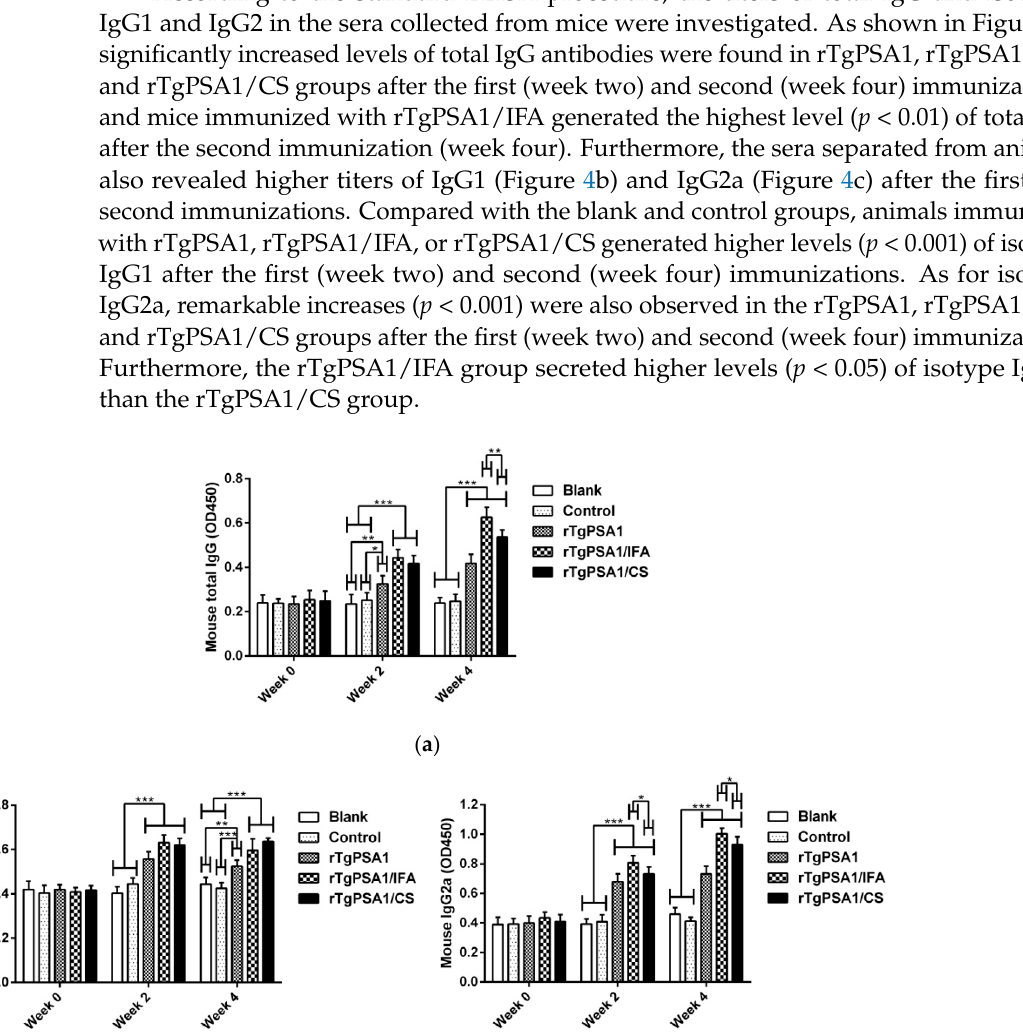
( d ) Figure 5. Cytokine secretions in mice. Commercially available ELISA kits were used to determine levels of ( a ) IFN- γ , ( b ) IL-4, ( c ) IL-10, and ( d ) IL-17 in mouse serum after the second immunization (week four). Each sample was conducted once. Results were estimated using one-way ANOVA tracked by Dunnett’s test, and values are shown as mean ± SD (n =